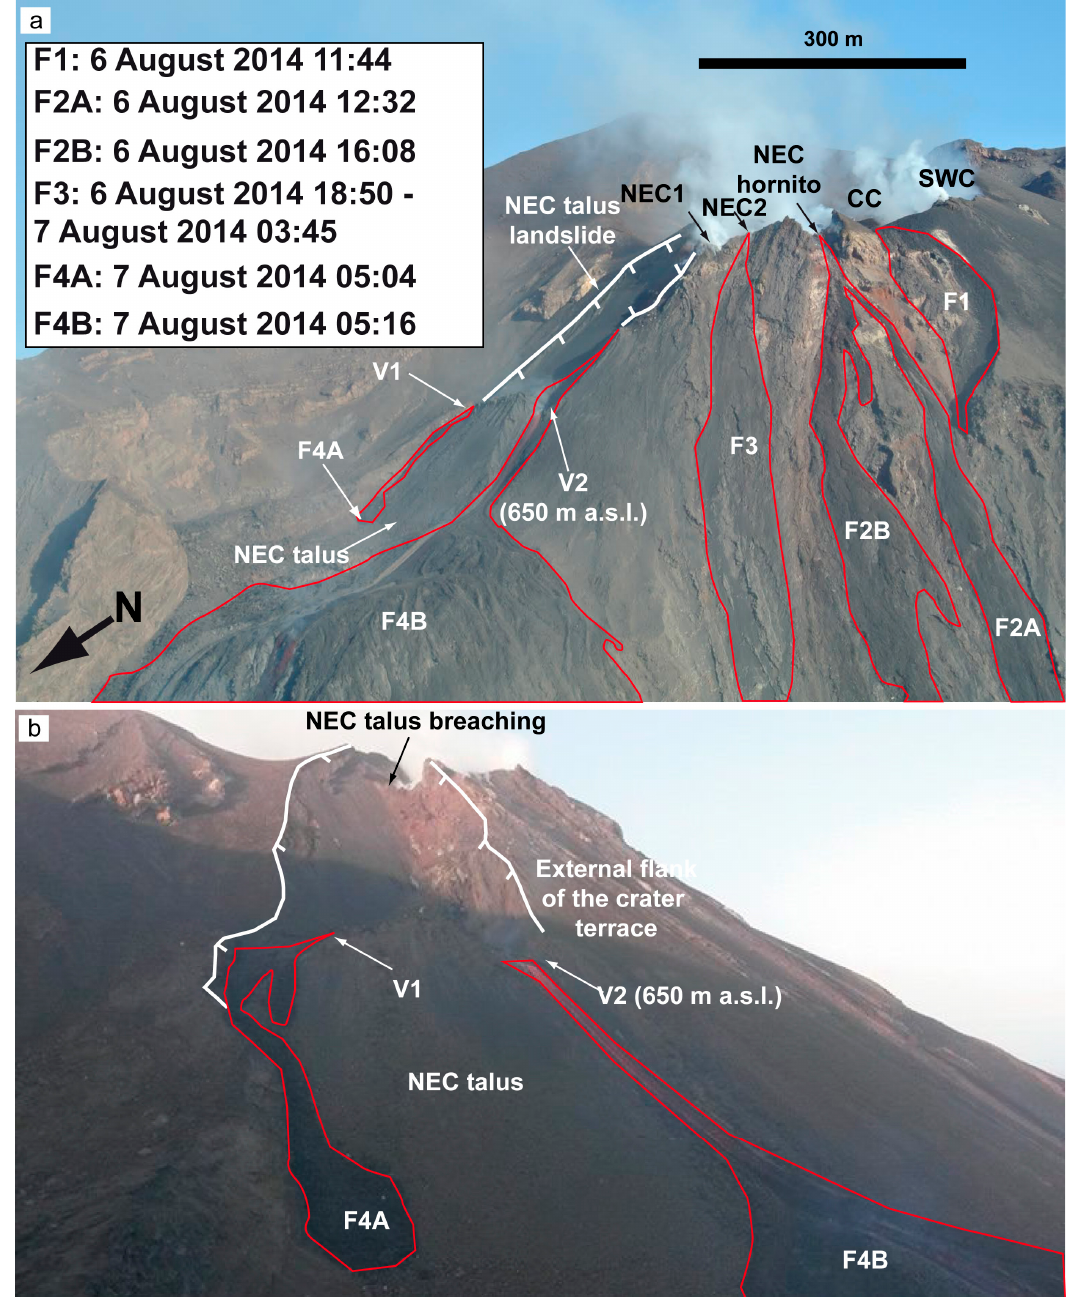
Figure 4. ( a ) The external flank of the crater terrace after the onset of the 2014 flank eruption (photo taken by INGV personnel on 11 August 2014 from helicopter survey). Lava overflows emitted during the run-up phase (F1 to F3) and lava flow produced during and after the onset (F4A and F4B) are also reported. ( b ) Detail of the NEC-talus area highlighting the scar produced during the onset of the eruption (7 August 2014), the first lava flow after crater breaching (F4A, erupted from vent V1), the upper portion of the 2014 lava flow field (F4B), and the vent of the 2014 flank eruption (V2) (photo taken by UNIFI personnel on 8 October 2014 from field survey). It is interesting to note the internal stratification in the NEC-talus remnants (consisting of volcaniclastic levels) that are continuous in all the inner walls of the landslide scar.